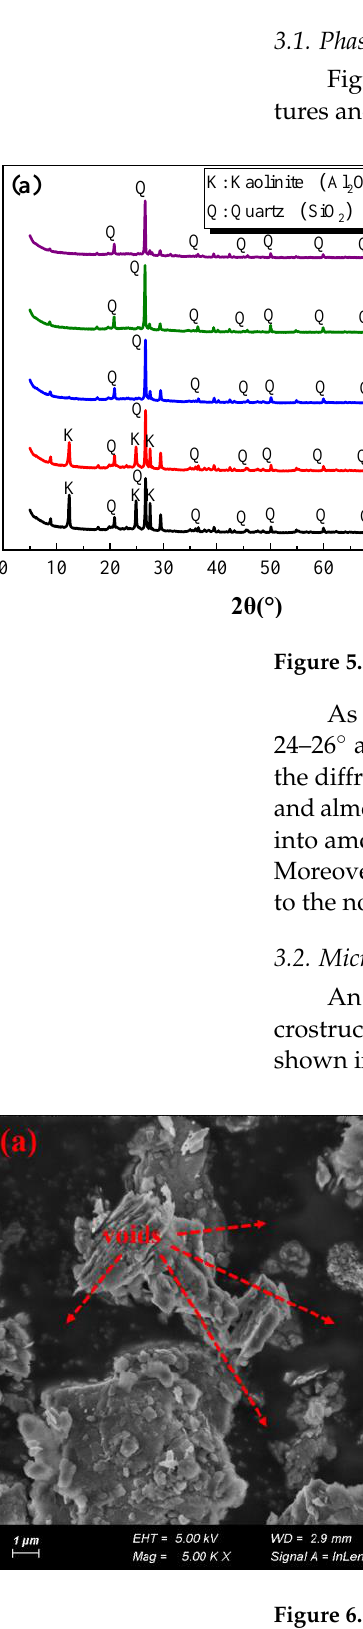
Figure 6. ESEM images of samples at ( a ) raw coal gangue, ( b ) calcined coal gangue.